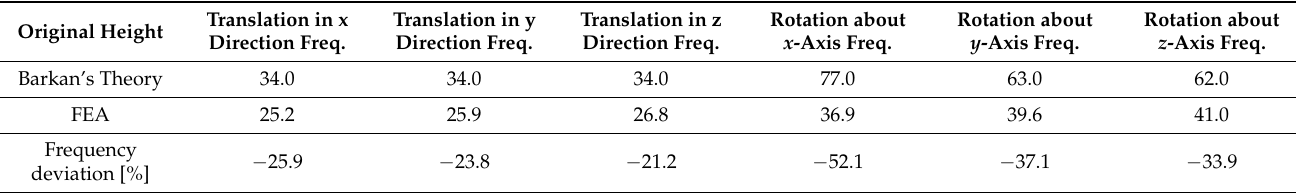
Table 4. Comparison between Barkan’s theory and FEM results in the 3rd Model low height. Translation in x Translation in y Original Height Direction Freq. Direction Freq.